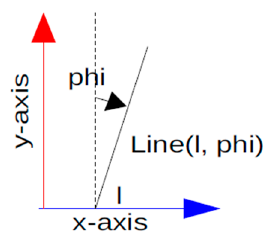
Figure 12. Line parametrization.